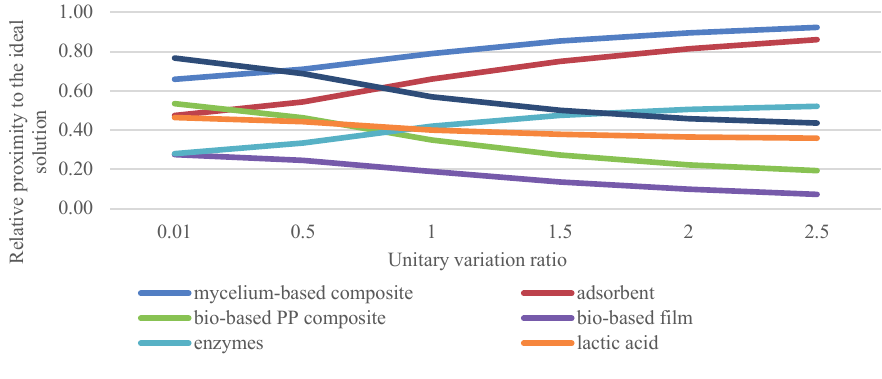
Fig. 2. Results of sensitivity analysis for product price comparison.